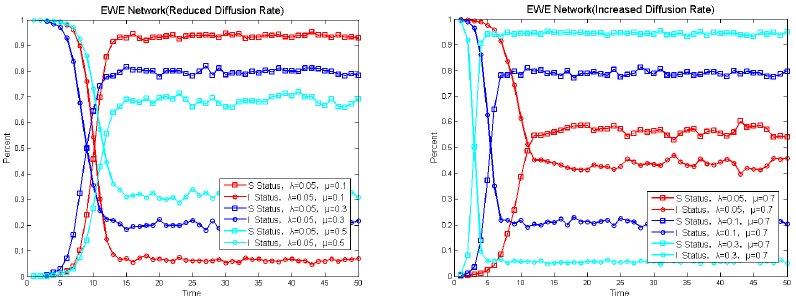
Figure 11. Influence of diffusion rate on spread in three-layer EWE network.